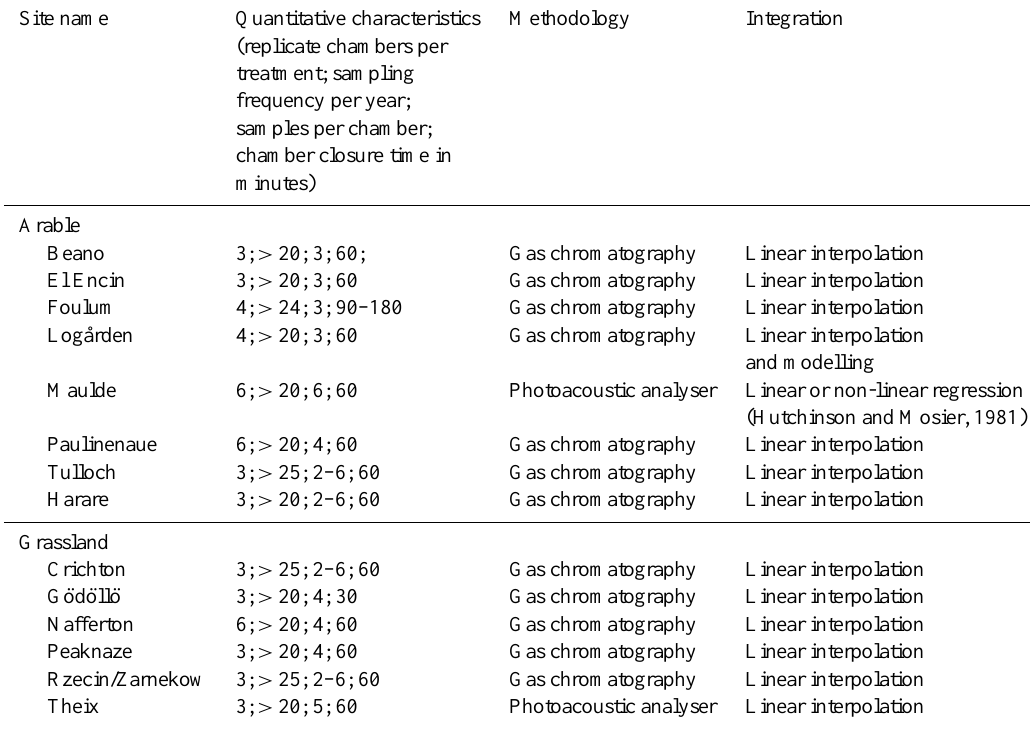
Table 2. A description of the experimental and analytical procedures used at each